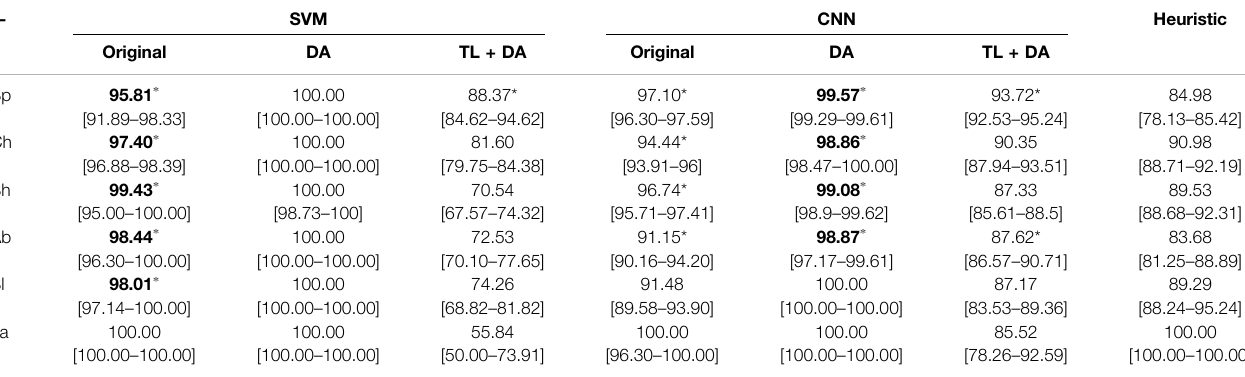
TABLE5| Performanceofthemachinelearningmodelsforeachofthesub-groupsoftheBSdataset.Theresultsarepresentedasmedianspeci fi city(25thpercentile — 75th percentile) (%). On the left side, the results for the SVM. On the middle, the results for the CNN. On the right side, the results using the heuristic method in Charlton et al. (2021). The best results of each model that performed better than the heuristic approach for each breathing type are in